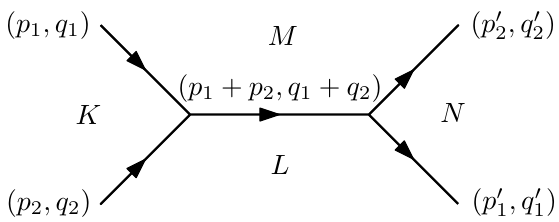
Figure 5. Any junction of two Y-diagrams can be put into this form by reversing the orientation of the legs and changing the signs of the corresponding labels. The parameters are subject to the constraints from (3.12).